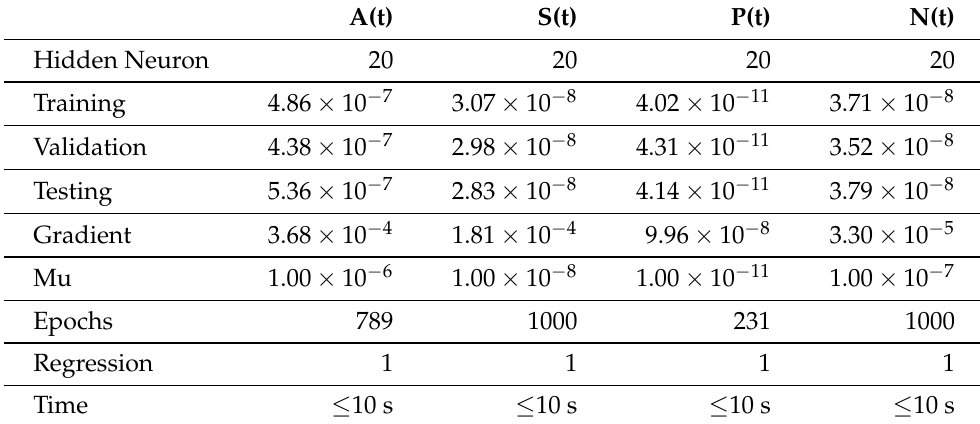
Table 5. Gradient, MSE, number of iterations, mu, and time spent by the computing system to get solutions for Case 3.